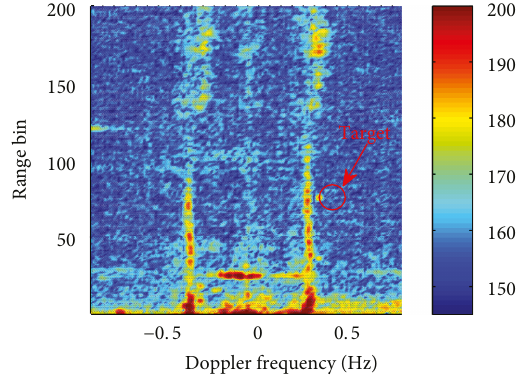
Figure 19: Range-Doppler map by the DBF method.